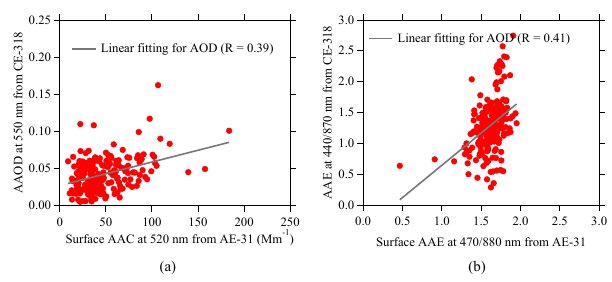
Figure 6. Comparisons between the absorbing aerosol optical depth (AAOD) at 550nm from CE-318 and surface absorption coefficient (AAC) at 520nm from AE-31 (a) and between the column AAE at 440 / 870nm from CE-318 and surface AAE at 470 / 880nm from AE-31 (b) in urban